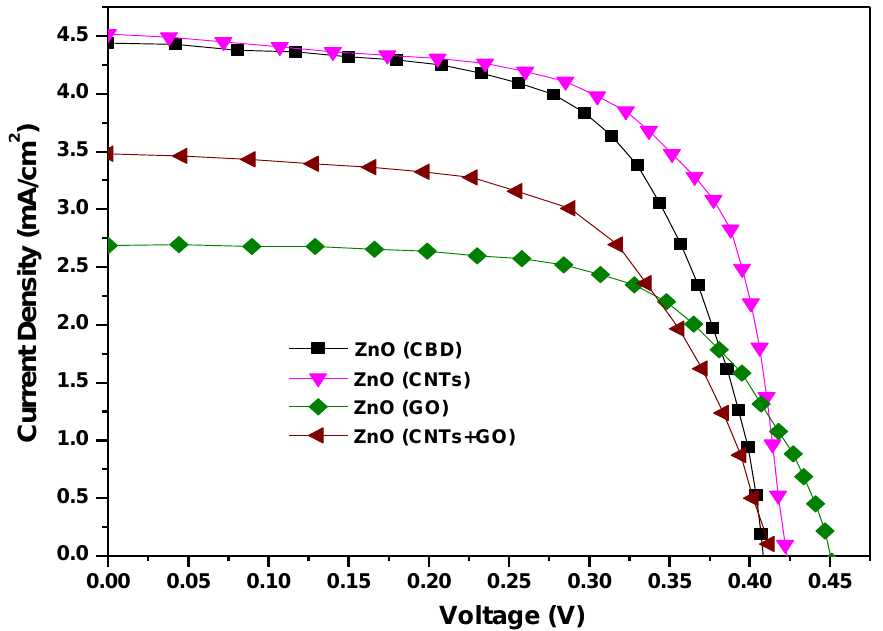
Figure 18. Electrical characteristics of ZnO nanostructures and ZnO nanocomposites with carbon.